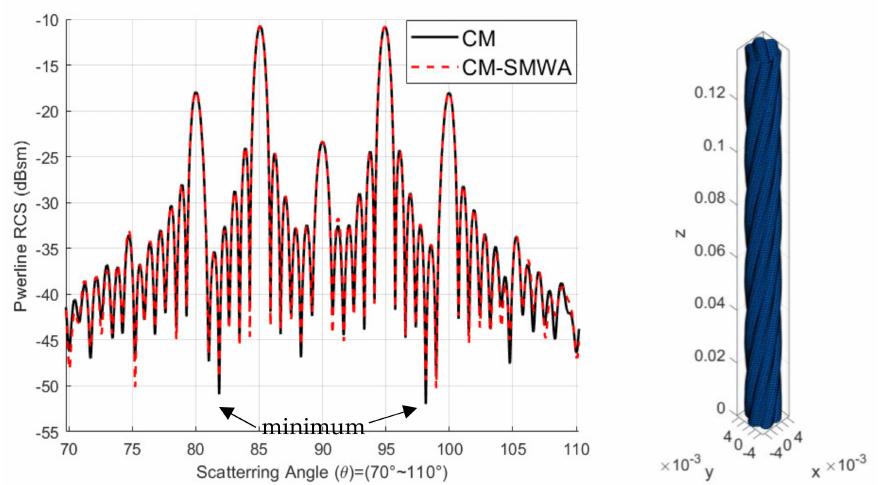
Figure 14. Simulation results of the power line RCS with the different algorithms at 76 GHz (V-V).